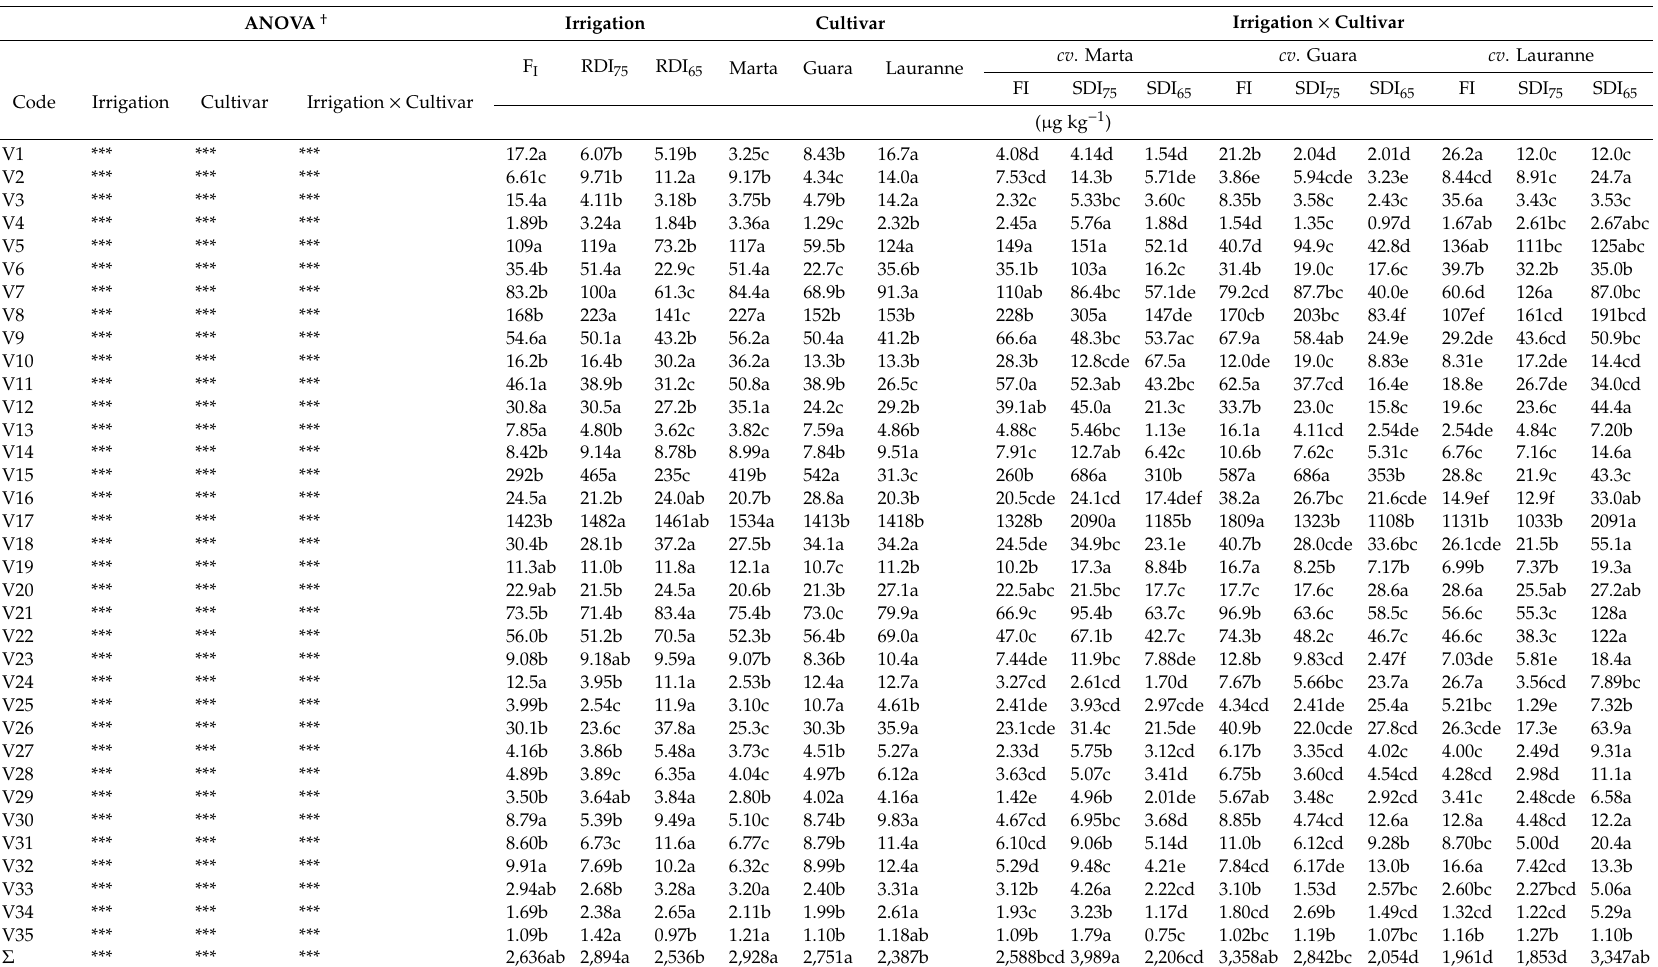
Table 6. Volatile compounds are based on the use of 2-acethyl thiazole as internal standard in raw